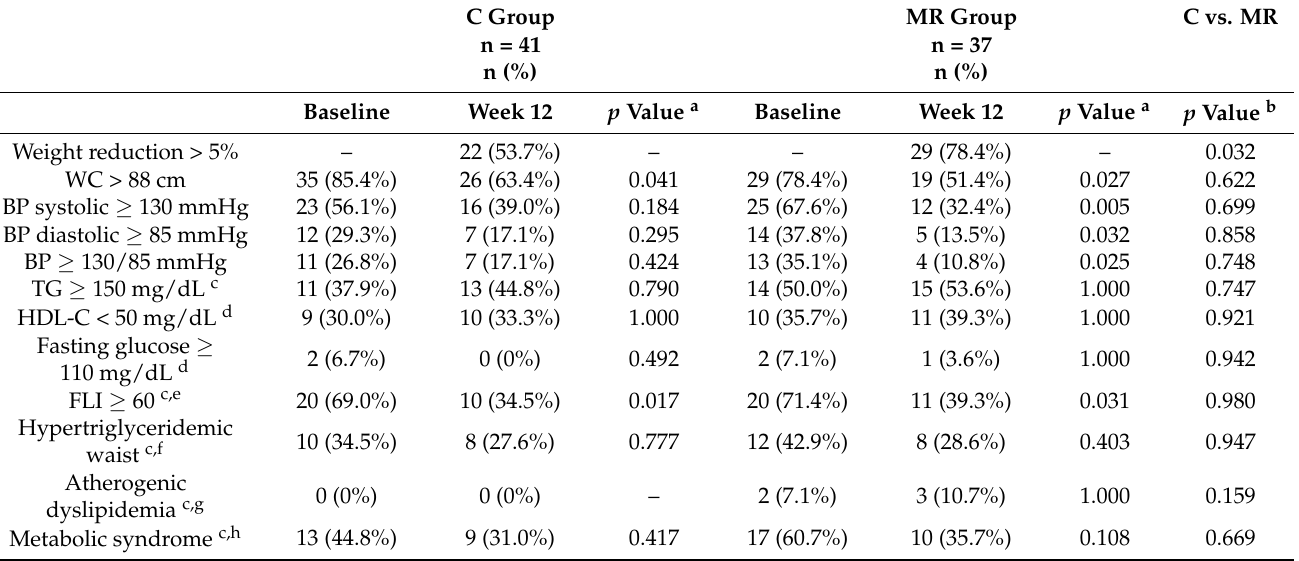
Table 3. Changes in the cardiometabolic risk profile in overweight women at baseline and after dietary